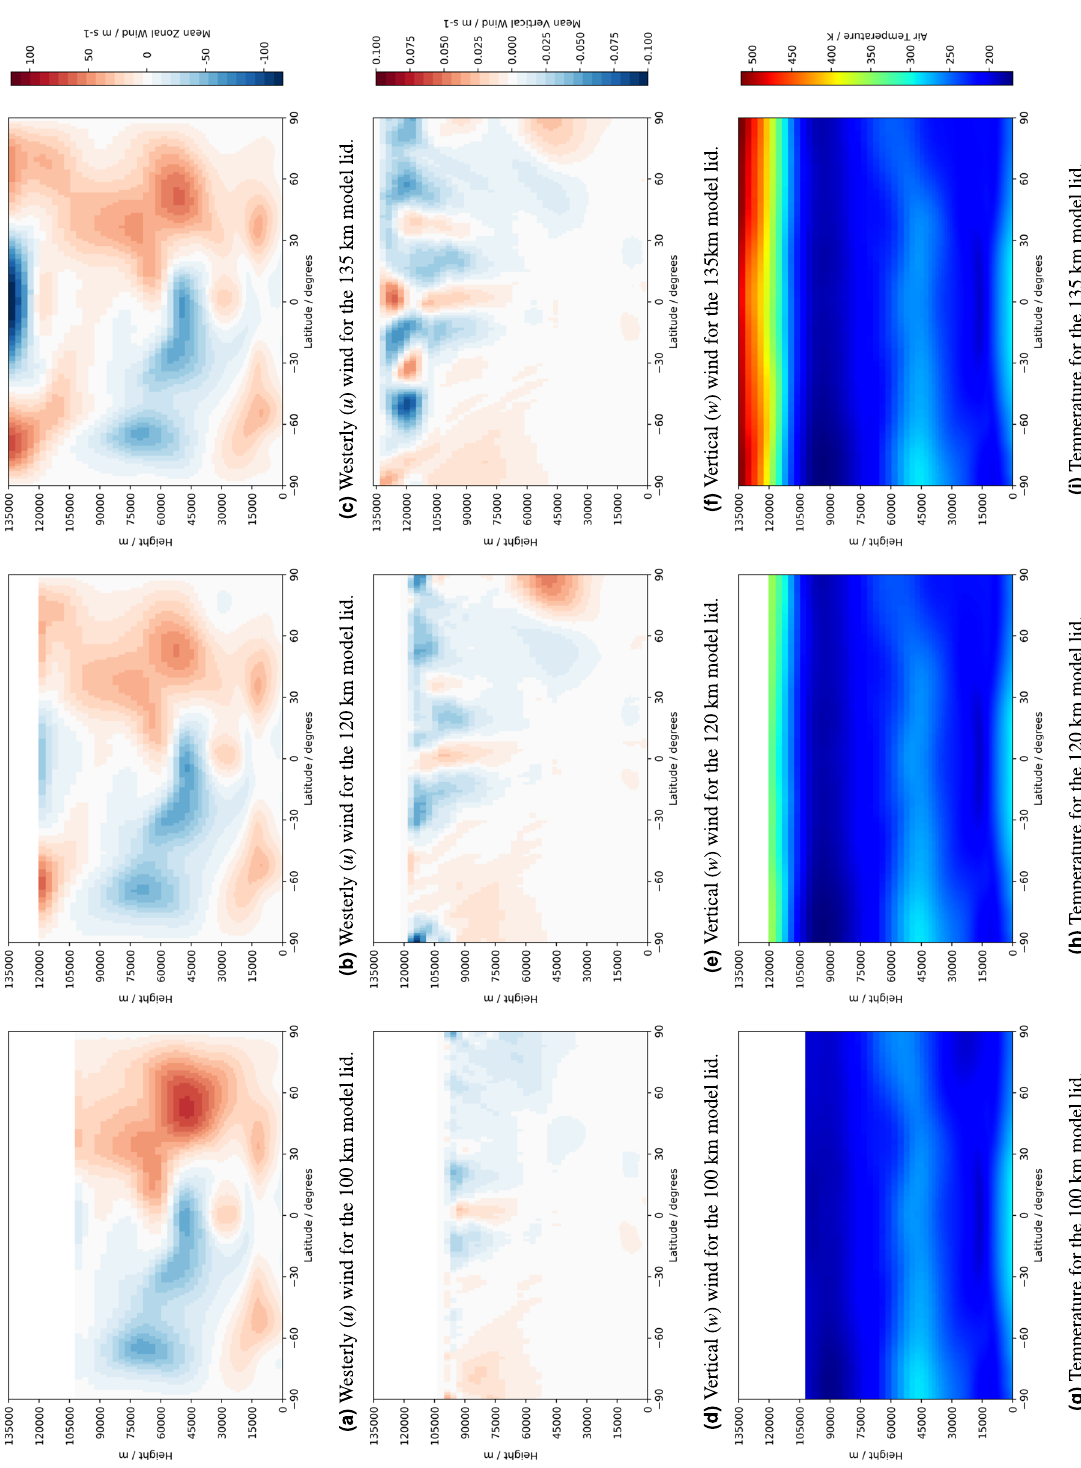
Fig. 18. Zonal mean monthly mean climatologies in December of westerly ( u ) wind (top), vertical ( w ) wind (middle) and temperature (bottom) comparing the nudged 100 km model run with the successful 120 and 135 km lid model